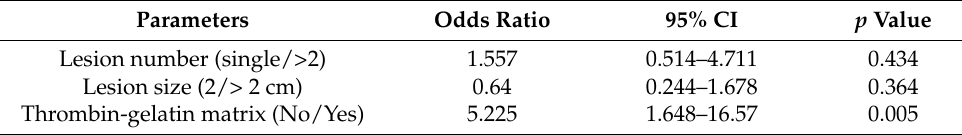
Table 4. Result of factors affecting acute Table 3. Result of factors affecting Hematoma.